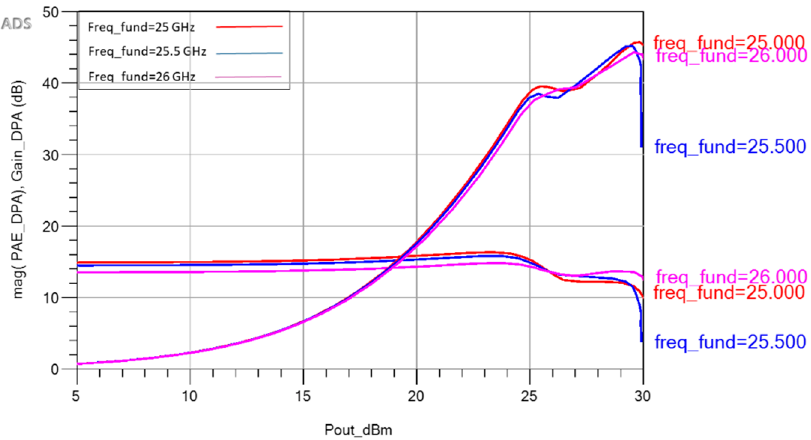
Figure 8. Simulated PAE and power gain vs. output power at the band of frequency (GHz).